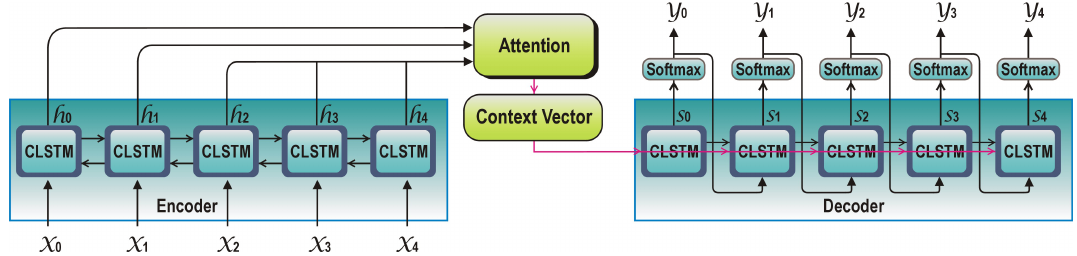
Figure 5. Bidirectional convolution recurrent encoder decoder architecture using attention